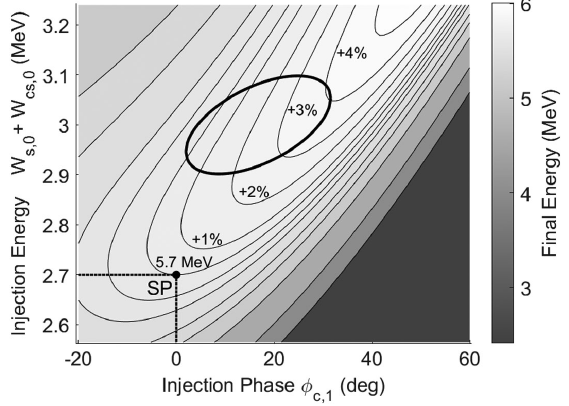
FIG. 7. Exit energy contour plot on the input energy-phase plane. The ellipse marks a preferable injection phase-space area, which results in small emittance growth, small transverse defocusing, and acceptable final energy spread (see Fig.